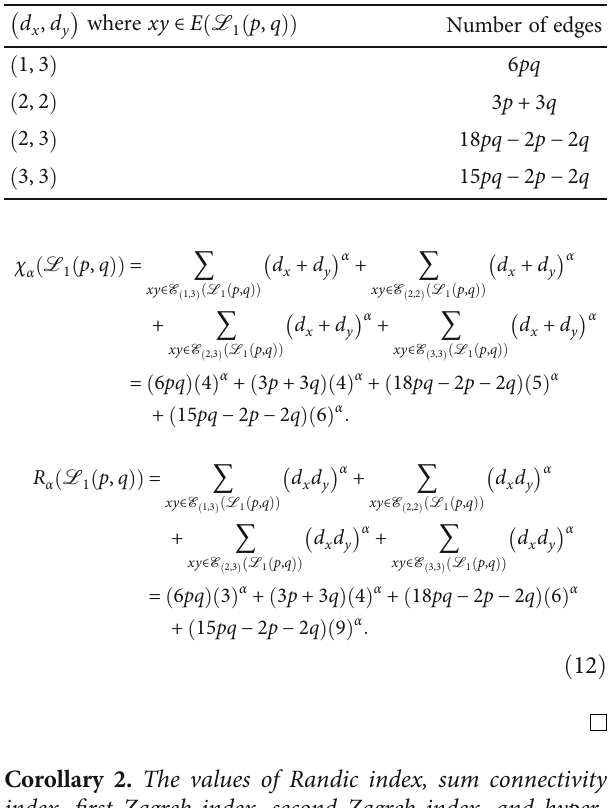
2, 2 Þ . The box represents a unit cell. 1 ð Table 1: The edge partition of L end vertices of each